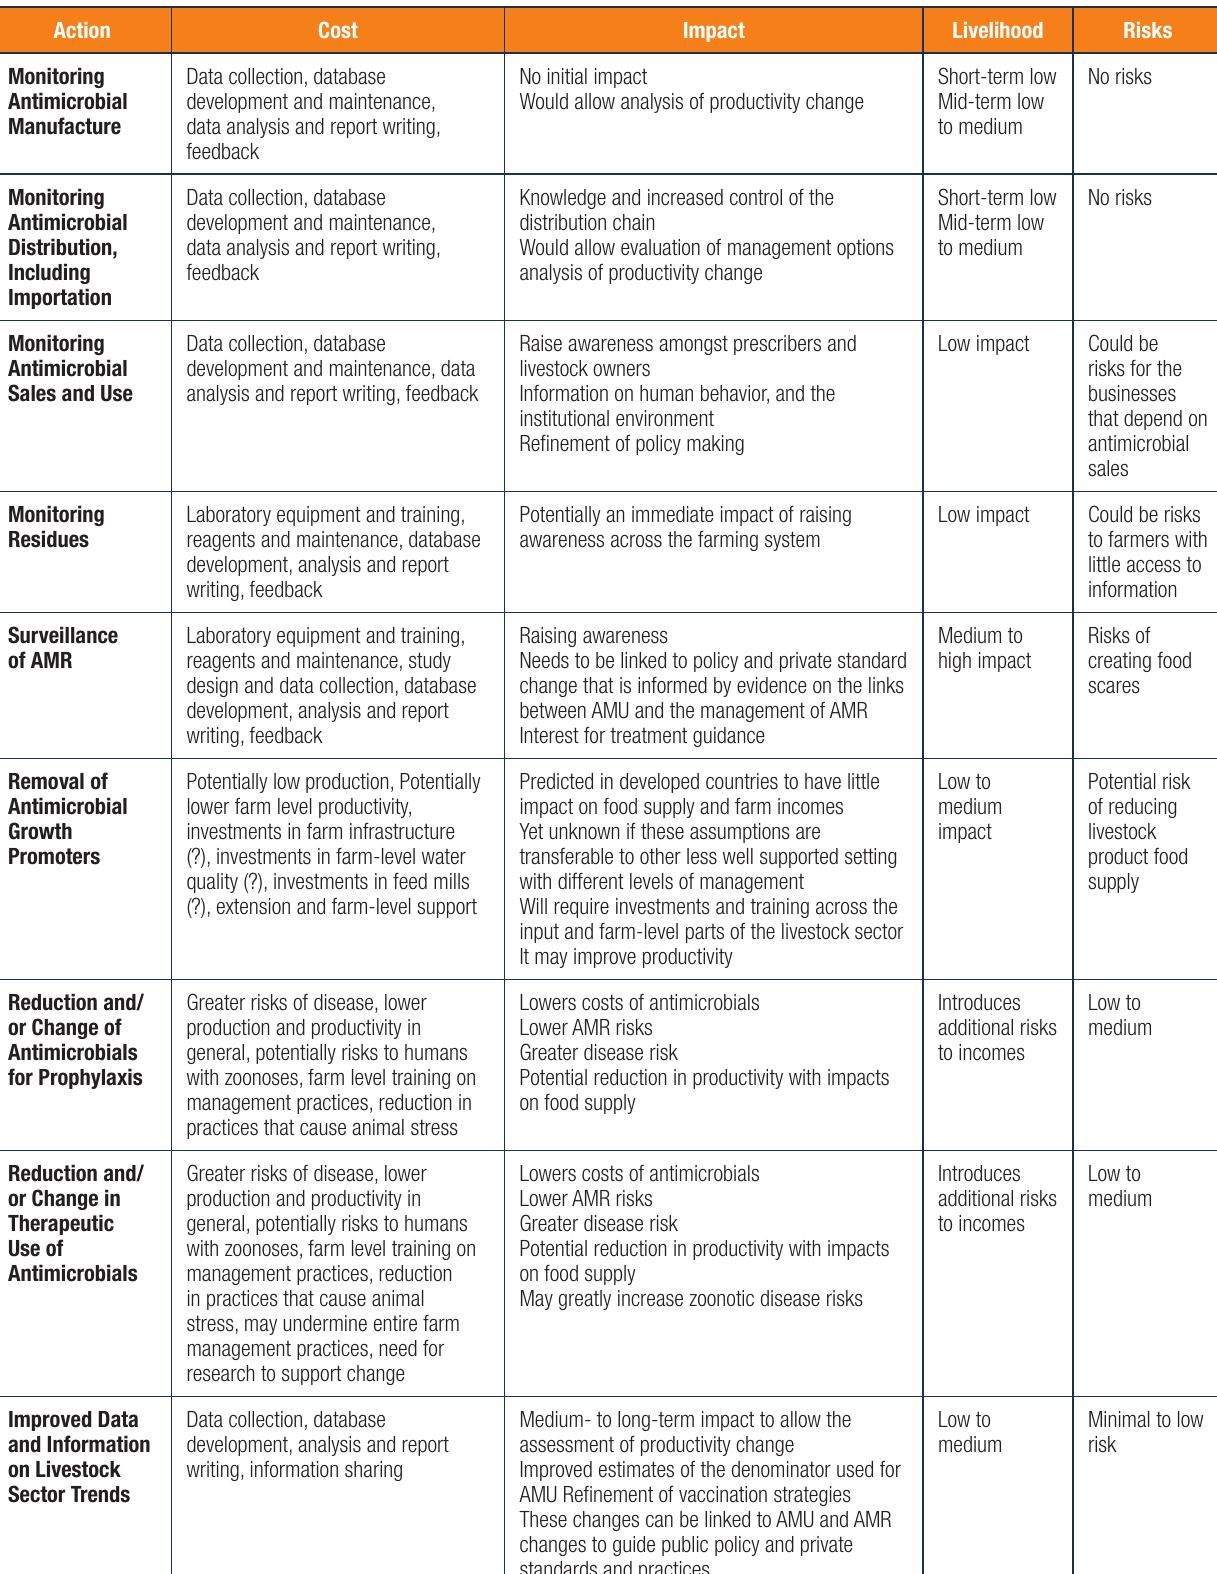
TABLE 6. Proposed List of Potential Country-Level Actions to Contain AMR in Livestock Estimated Costs, General Impact, Impact on Livelihoods, and Levels of Risk (Authors’